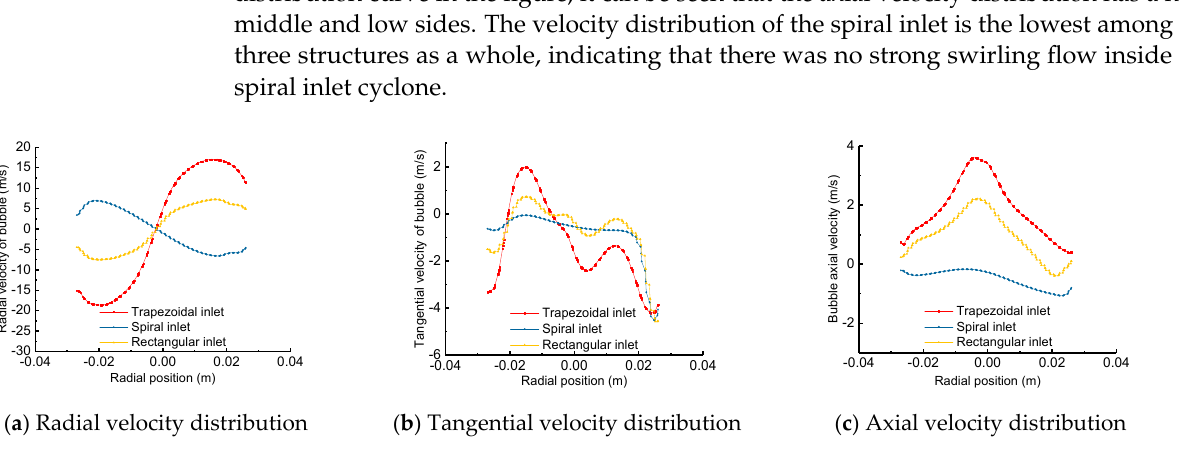
Figure 9. Section Z velocity distribution curve. It can be inferred from Figure 10 that when the inlet was rectangular, although the initial velocity was in the middle of the three, the trace was most concentrated at the bottom of the exhaust port, indicating that the bubble flow effect was the best. When the inlet was trapezoidal, although the maximum speed was the fastest, the concentration of the trace at the bottom of the exhaust port was slow, indicating that the bubble flow effect was poor. Combining the bubble velocity trace distribution and simulation analysis, it can be concluded that the gas discharge efficiency of the rectangular inlet was increased by 7% compared with that of the trapezoidal inlet cyclone.